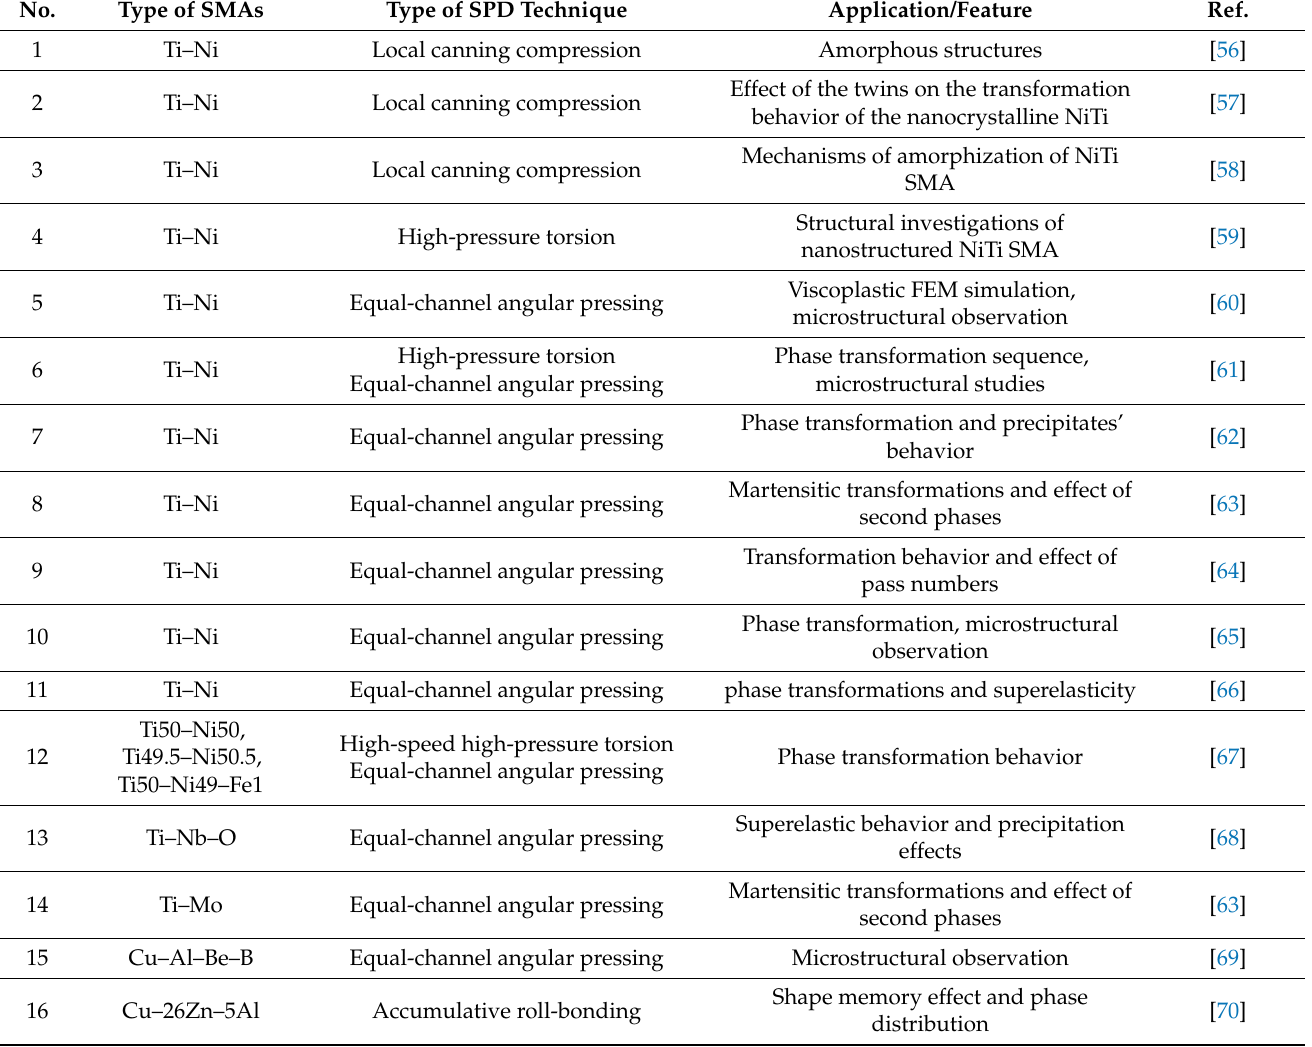
Table 1. Types of shape memory alloys, the applied severe plastic deformation methods, and their applications/features and details about the